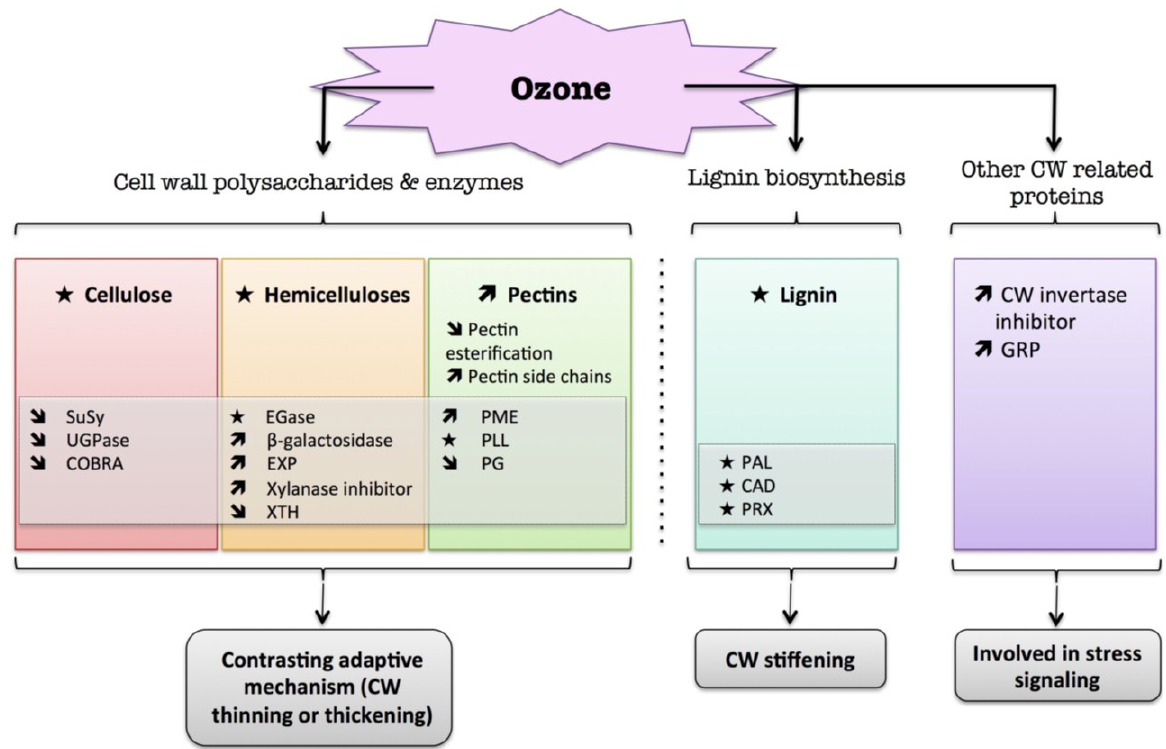
Figure 8. Diagram summarizing the plant cell wall response to ozone. The schematic presentation is deduced from the results of different studies reported in the review. Arrow (  ) means increased abundance and arrow (  ) means decreased abundance of the molecules. Star (  ) means contrasting data on the gene/protein or the molecule studied according to the literature cited in the review. Cell wall (CW);